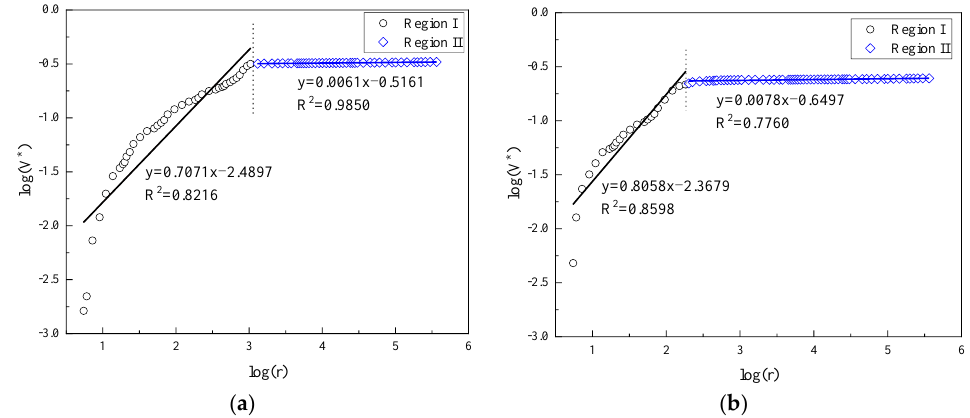
Figure 13. Multifractal characteristics of CCP30 at different ages under Ji’s model. ( a ) 3 days, ( b ) 28 days.